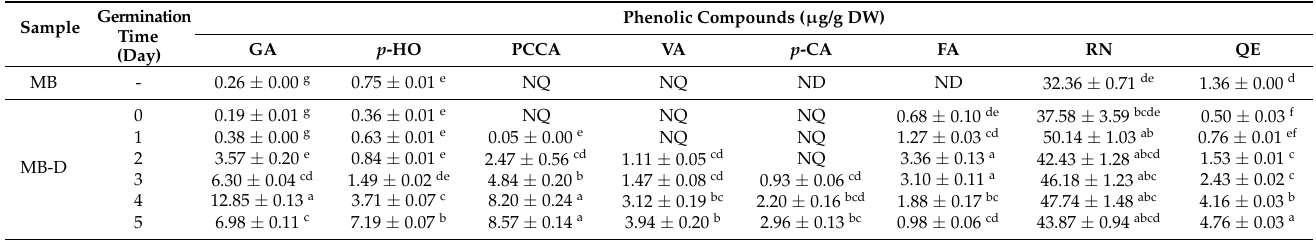
Table 1. Phenolic profile of mung bean (MB) seeds and sprouts germinated in darkness (0/24